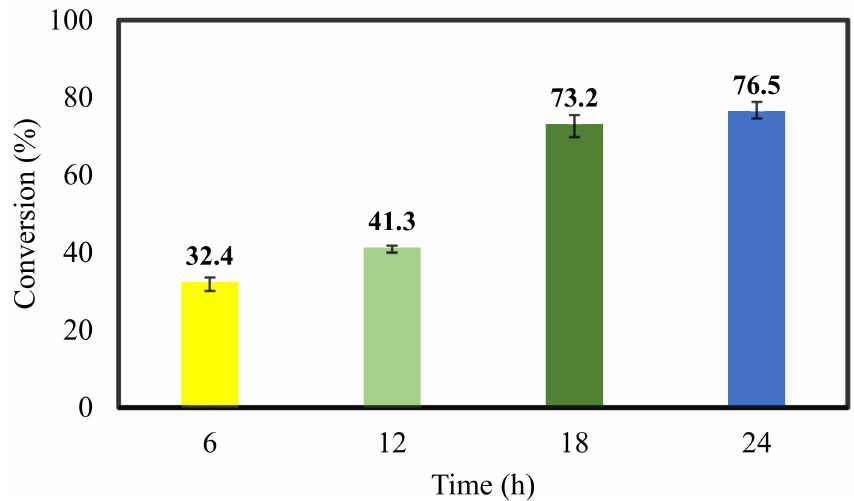
Figure 12. Influence of reaction time on furfural conversion. Conditions: furfural (10 mmol), base (Et 3 N) (10 mmol), formic acid (20 mmol), temperature 160 ◦ C, @PdCassCat catalyst amount (40 mg).